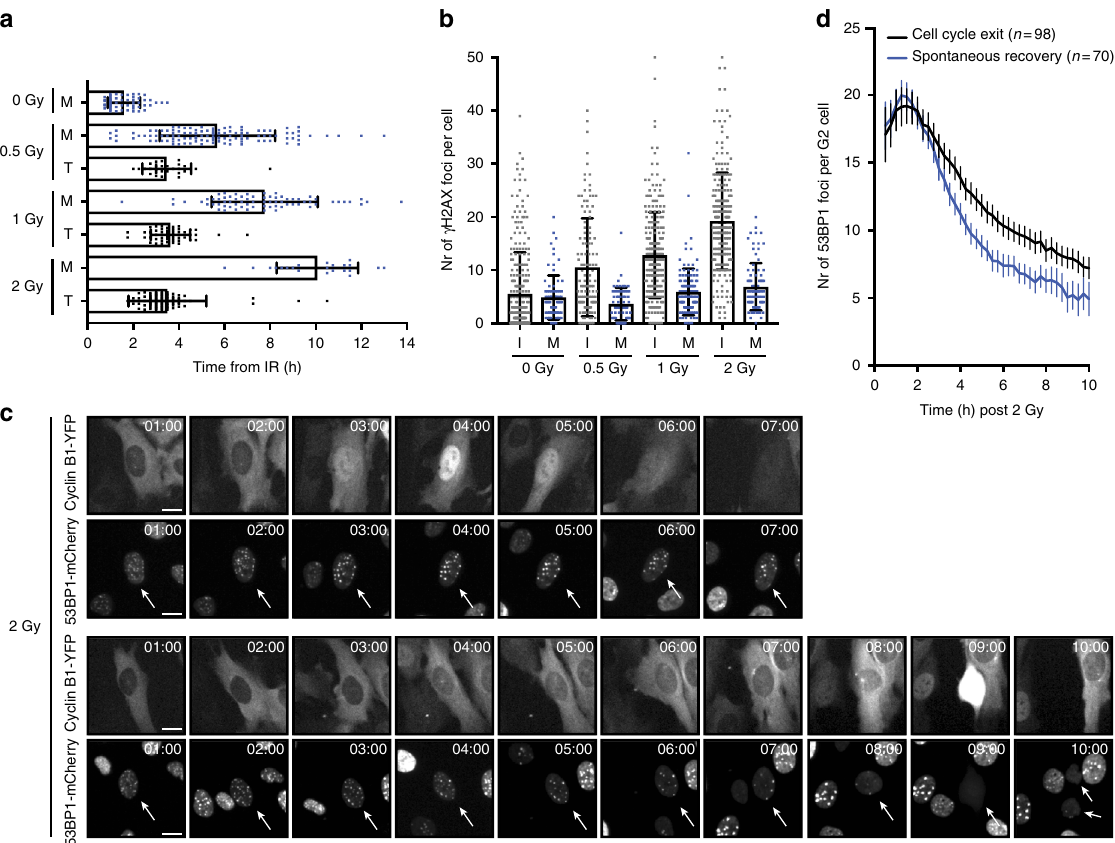
Fig. 1 Spontaneous recovery awaits successful repair. a Timing of cell cycle exit by onset of Cyclin B1 translocation (T) or spontaneous recovery by mitotic entry (M) after IR with indicated doses. Pooled cells from three independent exp. n > 20 Mean + sd. b Number of γ H2AX foci in interphase (I) cells 1 h after IR and recovering (mitotic, M) cells collected 5 – 7 h after IR with indicated doses. Pooled cells from three independent exp. n > 65 + sd. c Stills representing RPE CCNB1 YFP cells that enter mitosis or that translocate Cyclin B1 after IR (2 Gy) and the corresponding 53BP1 mCherry signal in the nucleus. Scale bar 10 μ m. d Quanti fi cation of 53BP1 foci from live cell imaging at indicated timepoints after IR in cells that recover spontaneously and cells that translocate Cyclin B1. n = number of cells pooled from three independent experiments + 95% con fi dence